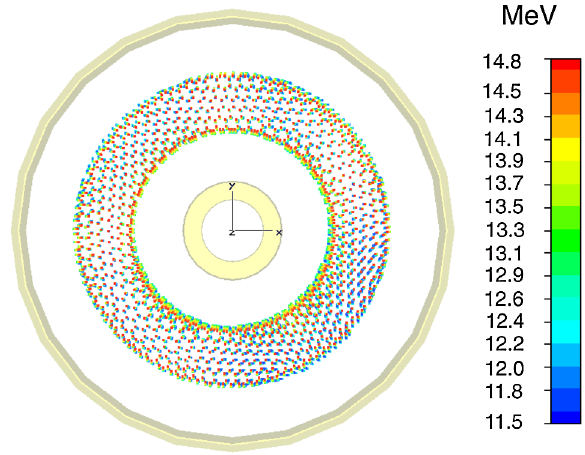
FIG. 22. (Color) Front view of the last bunch in a train of four bunches after 0.67 nsec following injection of the first bunch. The head of this bunch is located at 170 mm from the structure input. Different colors of simulated electrons indicate different energy losses. Dielectric tubes are marked with yellow